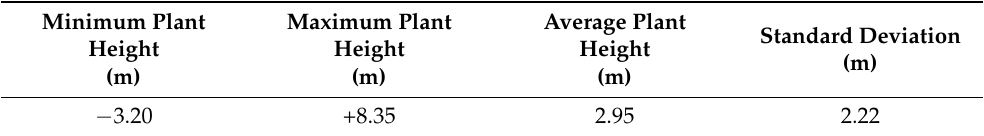
Figure 12. DEMs generated using Sentinel-1 satellite image pairs for the study area: ( a ) DTM generated using the first satellite image pair acquired on 2 and 8 August; ( b ) DSM generated using the second satellite image pair acquired on 20 and 26 October. Table 6. Minimum, maximum, and average plant height calculated using Sentinel-1 satellite image pairs and standard